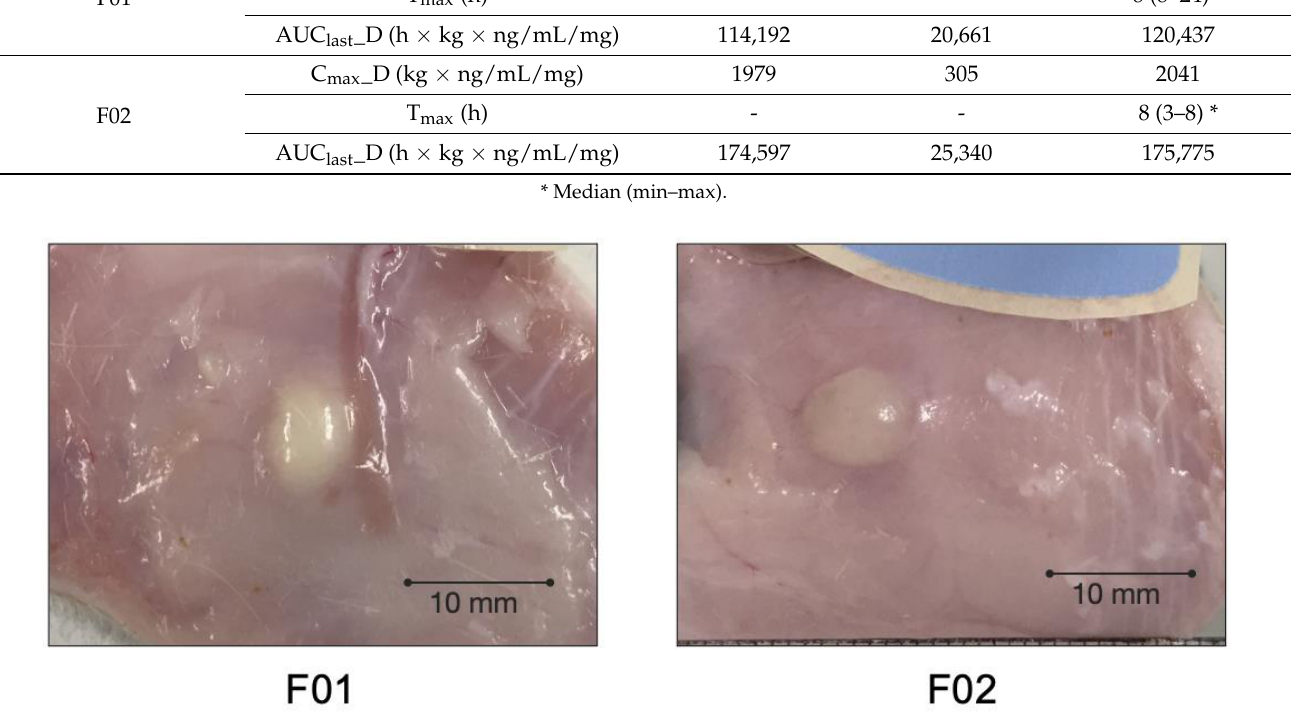
Figure 7. Photos of the injection sites 28 days post administration to rats of a PEG–PTMC-based suspension formulations with either a triblock (F01) or a diblock (F02) copolymer.